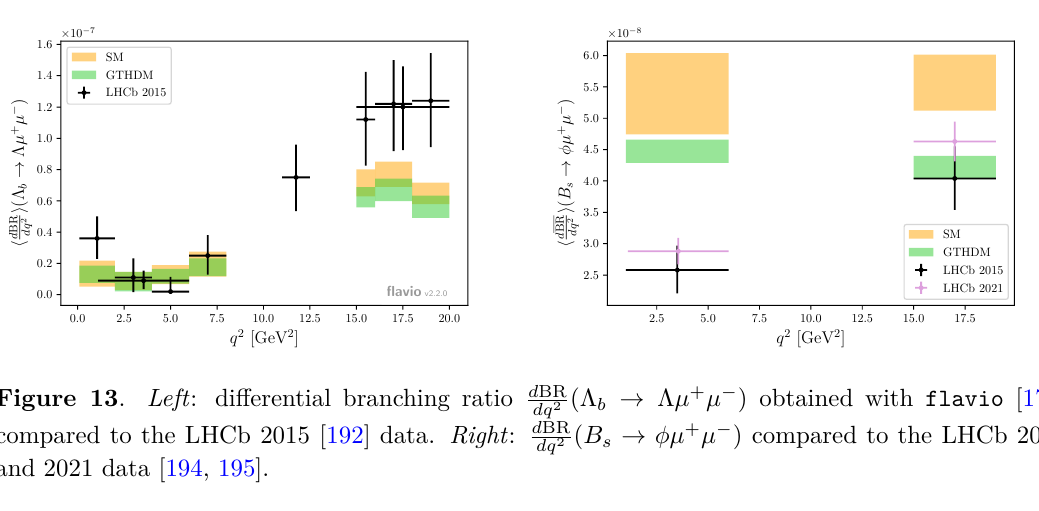
Figure 12 . Left : differential branching ratio for d BR data [189]. Right : d BR ( B + → K + µ + µ − ) compared to the LHCb 2012 and 2014 measurements [190, dq 2 191].